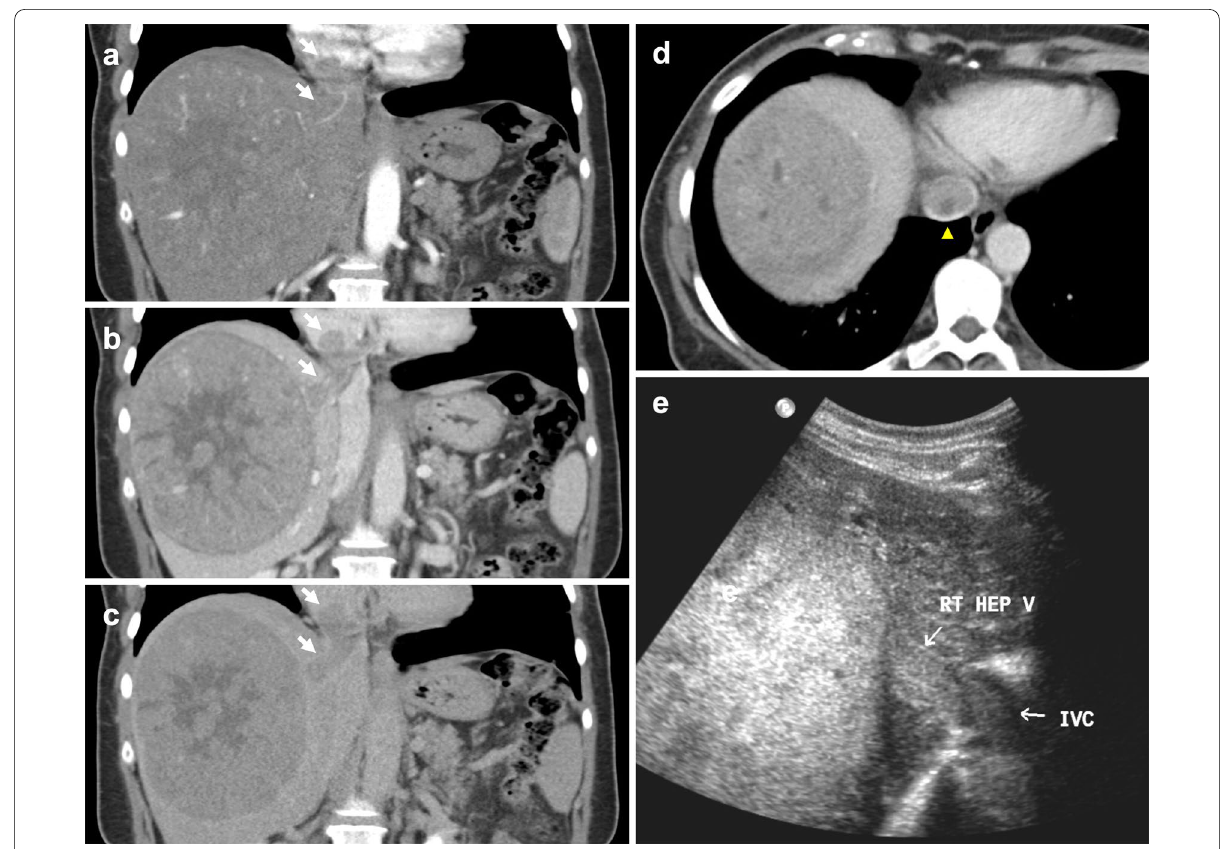
Fig. 18 Hepatocellular carcinoma invading the IVC. a–c Coronal multiphase CT images show a 12 the hepatic and supradiaphragmatic IVC. The thrombus (arrows) demonstrates enhancement in both ( a ) arterial and ( b ) portal venous phases, with complete washout in the ( c ) delayed phase. d Axial CT shows near complete obstruction of the hepatic IVC (arrowhead). e US